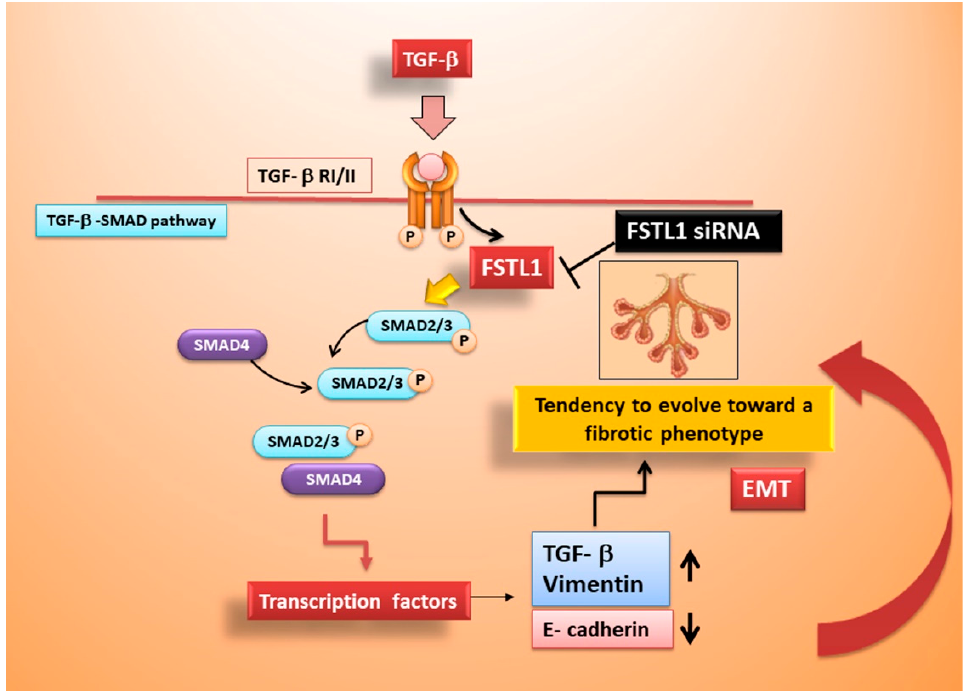
Figure 6. Schematic representation of FSTL1 role in TGF- β 1-induced EMT in SS.